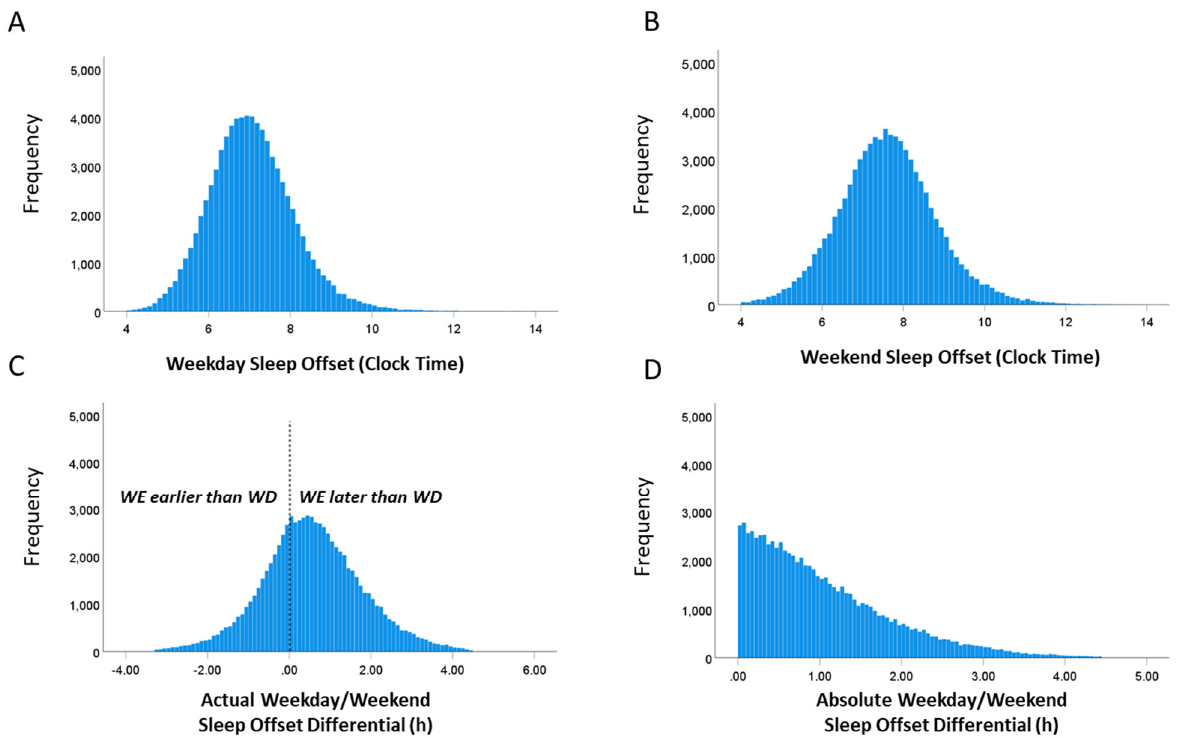
Figure 1. Histograms showing the distributions of ( A ) timing of sleep offset on weekdays, ( B ) timing of sleep offset on weekends, ( C ) actual weekday/weekend sleep offset differentials (negative values indicate that sleep offset timing is earlier on weekends than on weekdays), and ( D ) the weekday/weekend sleep offset differential expressed as absolute values.